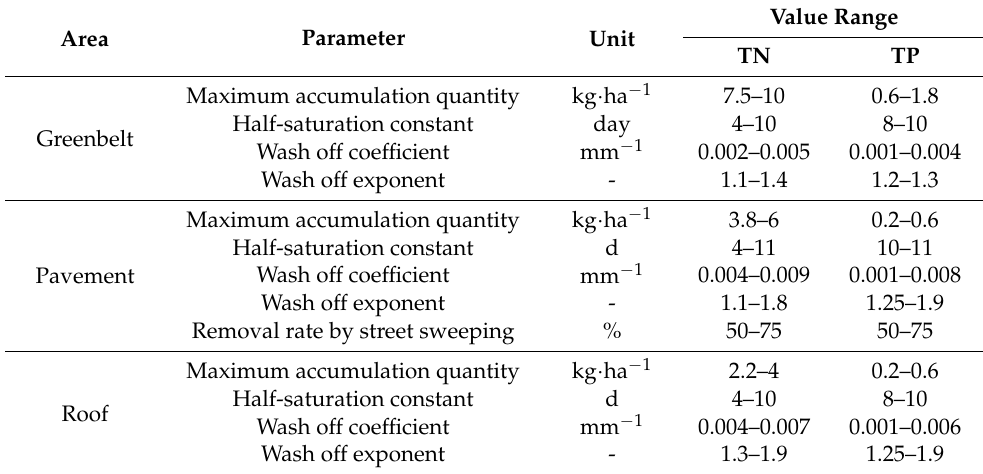
Table 2. Value ranges of water quality parameters on different land surface units in